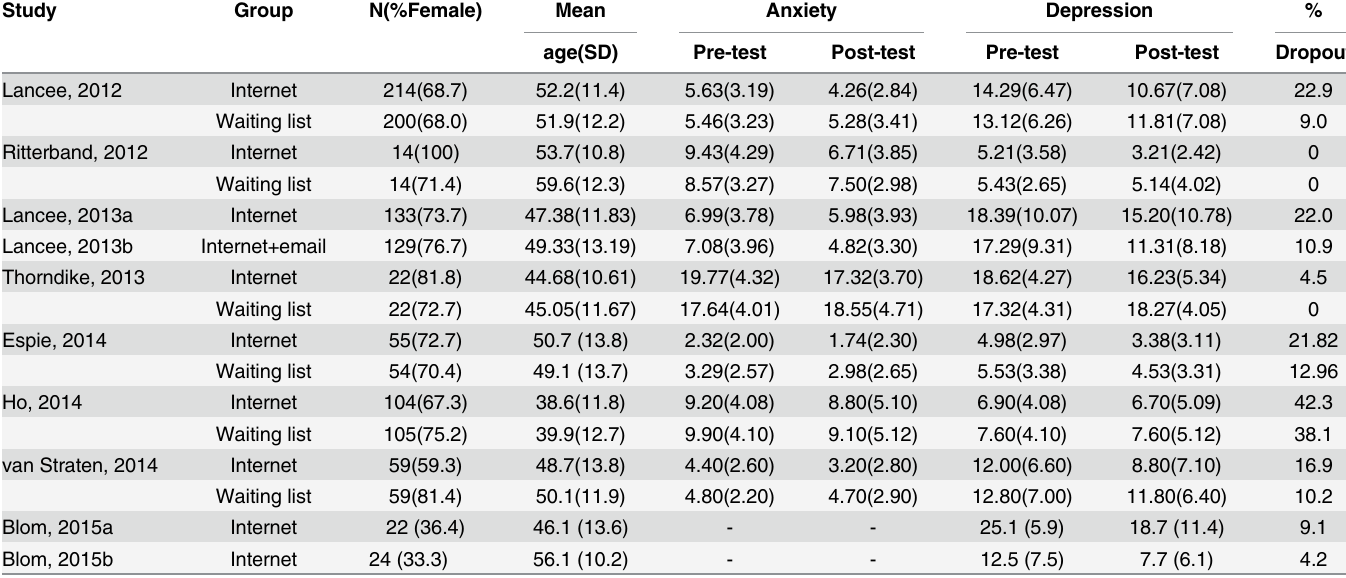
Table 2. Sample characteristics and rating scores of comorbid anxiety and